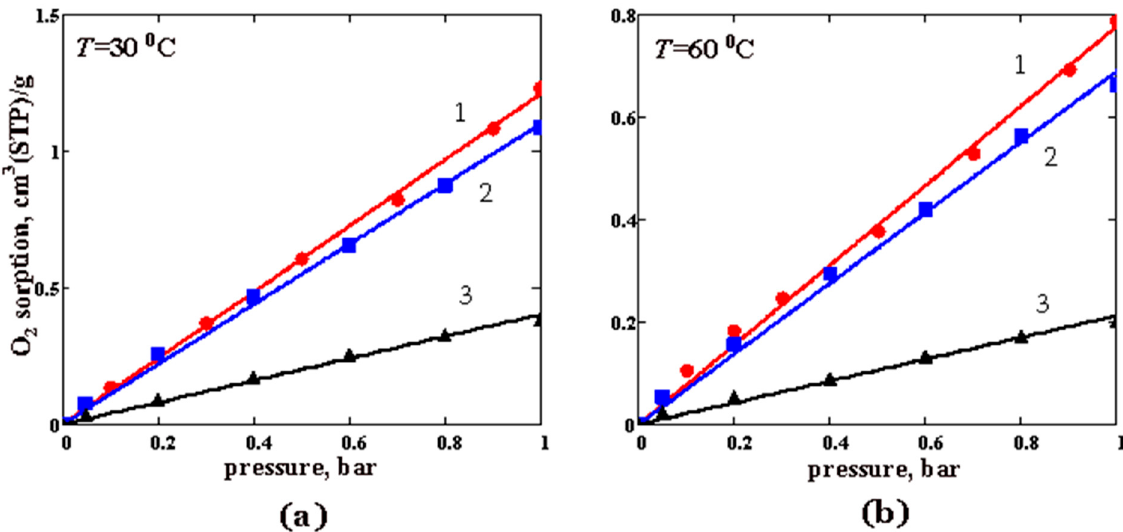
Figure 7. The oxygen sorption isotherms for PTMSP and PTMSP/PVTMS blends at the temperatures: ( a ) 30 °C and ( b ) 60 °C. The numbers 1, 2, and 3 denote pure PTMSP, blend #4 and blend #6, respectively. Points—experimental data, lines—approximation of the experimental data by a linear function of gas pressure.